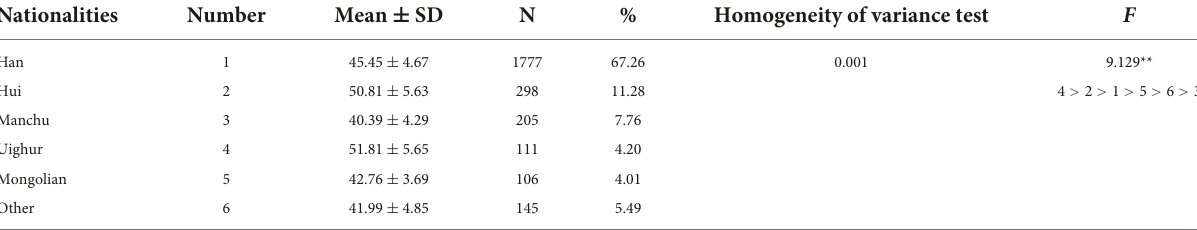
TABLE 8 Comparison of GSI T-score among different nationalities.